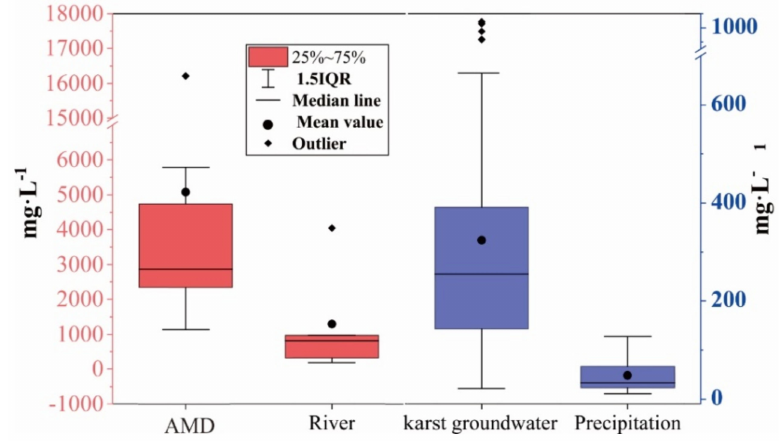
Figure 15. Box chart of SO 42 − .